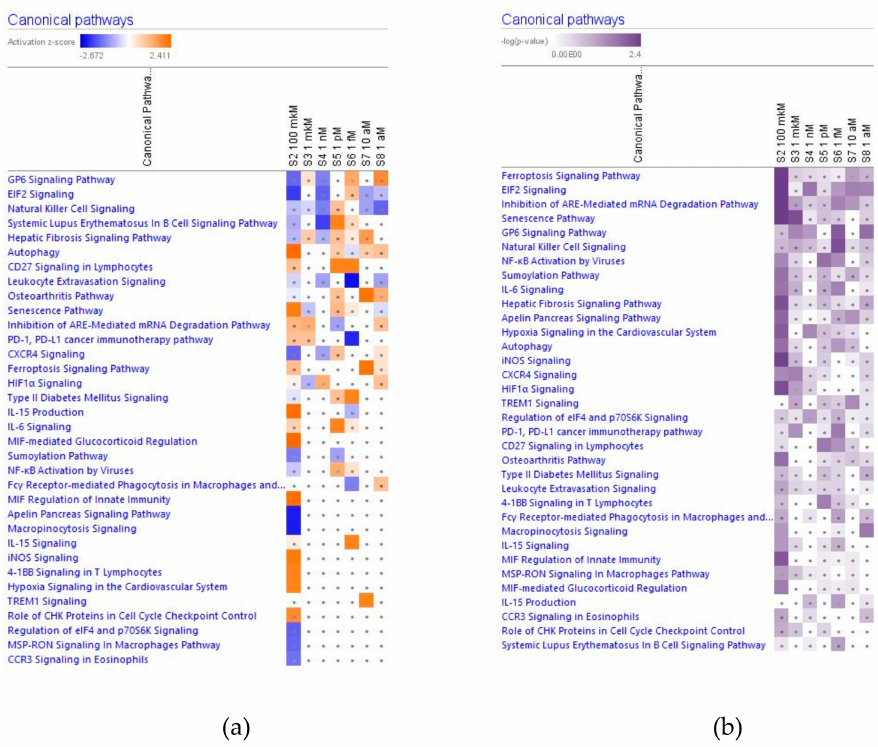
Figure 3. Effect of Rg5 in concentrations of 1 aM, 10 aM, 1 fM, 1 pM, 1 nM, 1 µ M and 100 µ M) on cellular immune response, stress and injury (including senescence and EIF2 signaling) signaling. ( a ) The brown color depicts predicted activation, blue color—predicted inhibition of signaling pathway; the symbol shows that the activation z-score was <2. ( b ) the symbol shows that the − log p -value was <1.3.